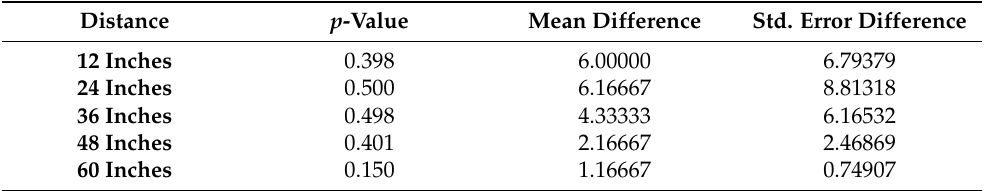
Table 3. Comparison of the mean aerosol and splatter produced by two-hole and four-hole handpiece. Distance